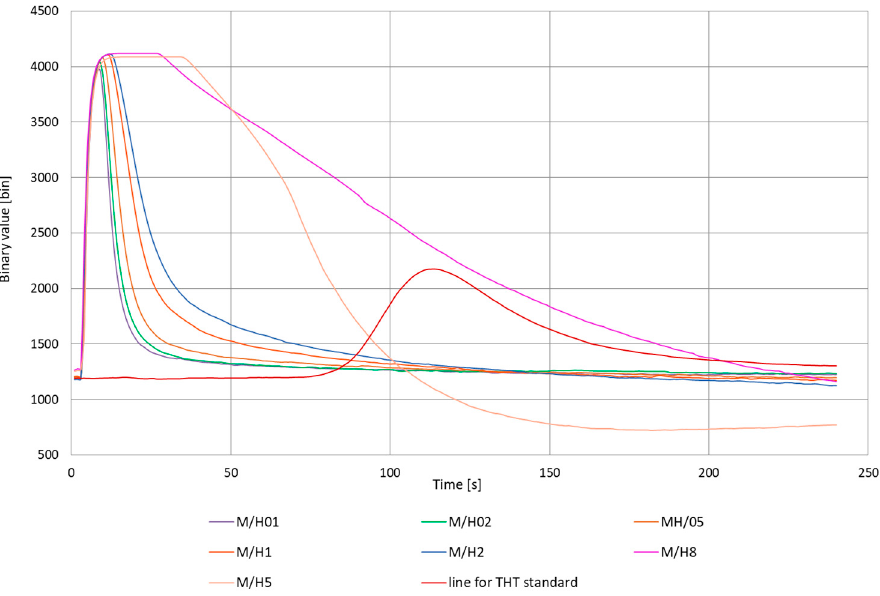
Figure 4. Graph showing the dependence between Type III analyzer response and hydrogen concentration, recorded for M/H01 to M/H8 mixtures.